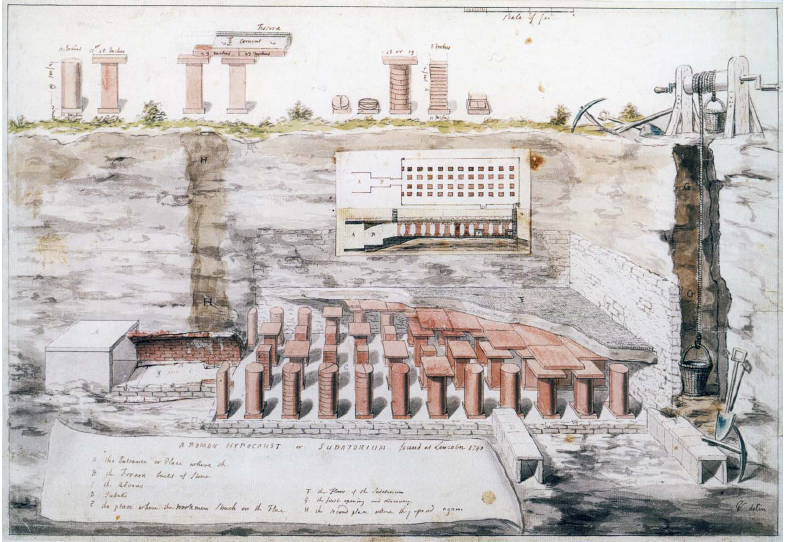
Figure 3. Excavation of a Hypocaust at Lincoln by George Vertue 1740